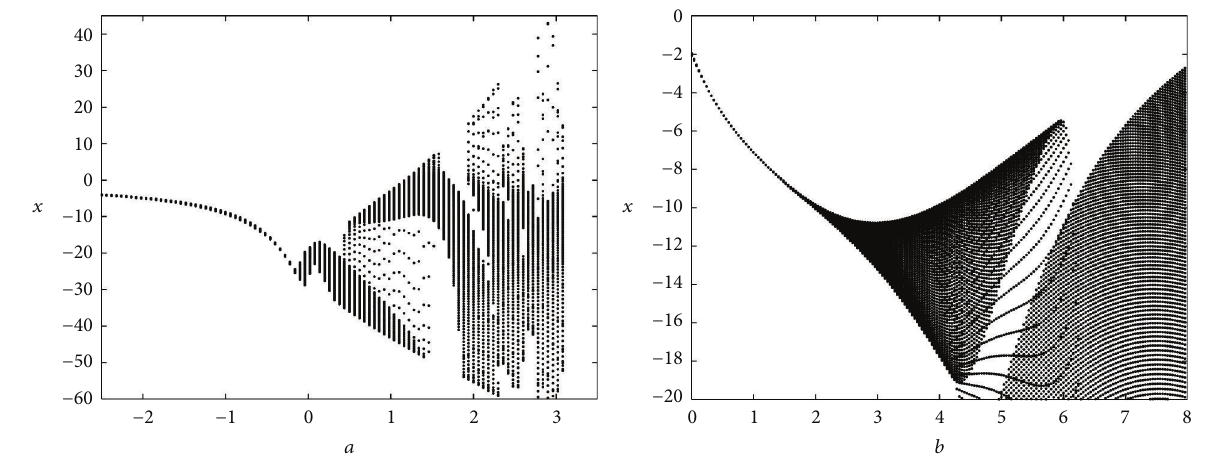
(a) Bifurcation diagram with the change of 𝑎 , when 𝑏 = 9, 𝑐 = 5, 𝑑 = 0.06, and 𝑒 = 25